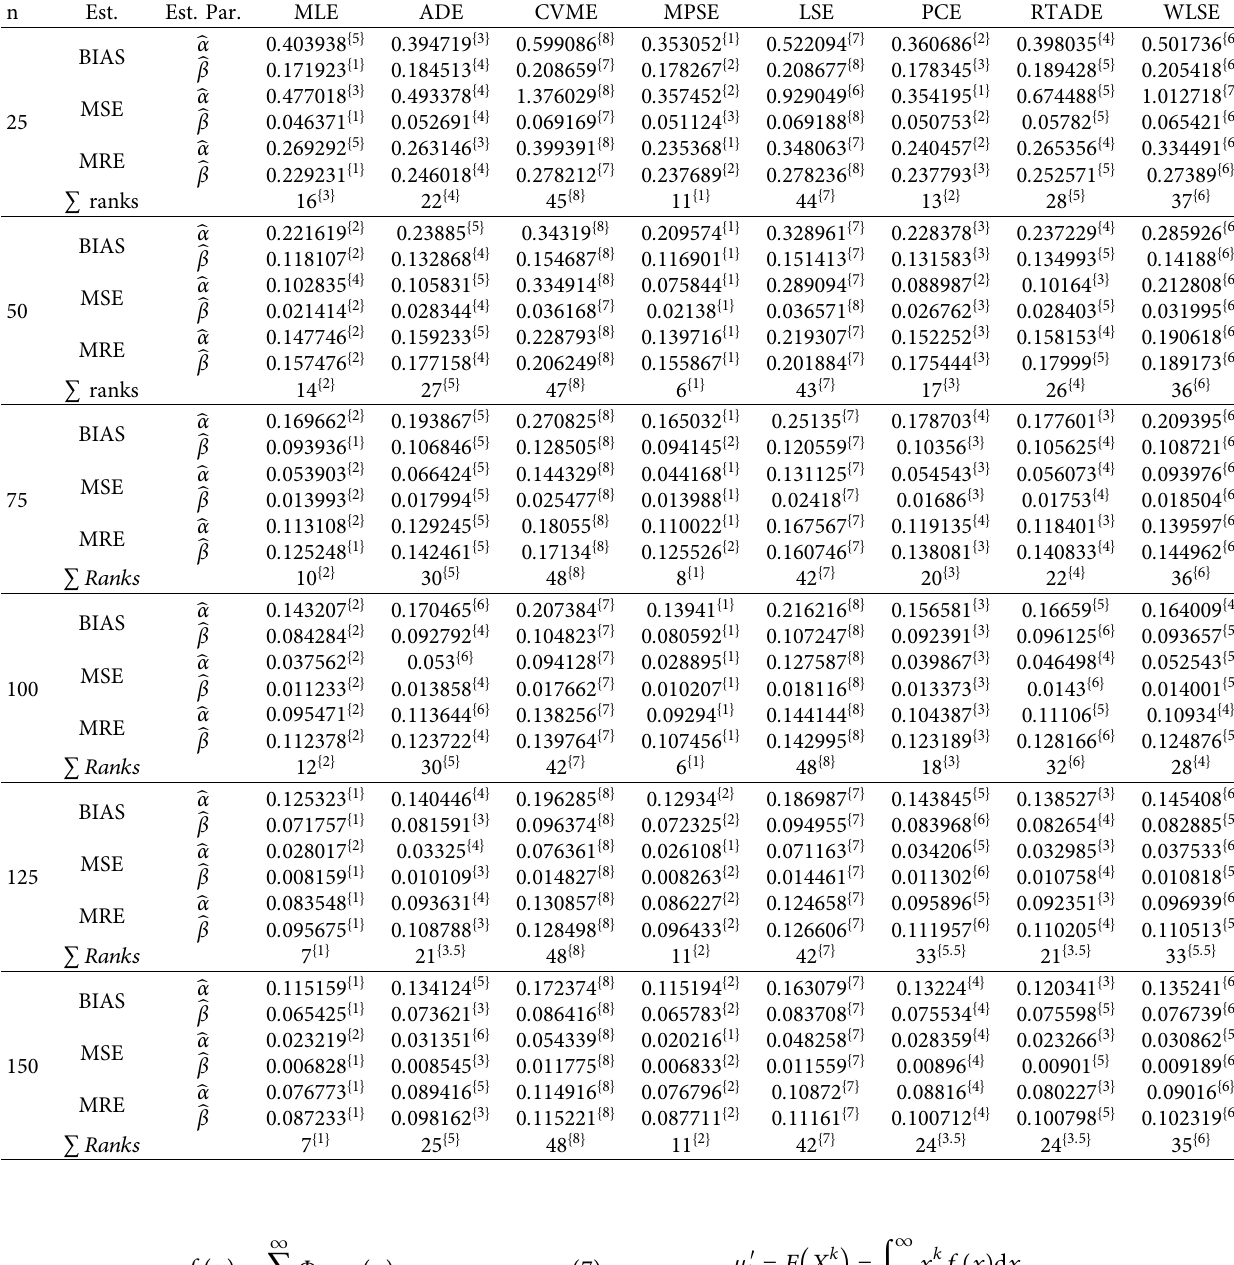
Table 3: Simulation values of BIAS, MSE, and MRE for α � 1 . 5 , β � 0 .